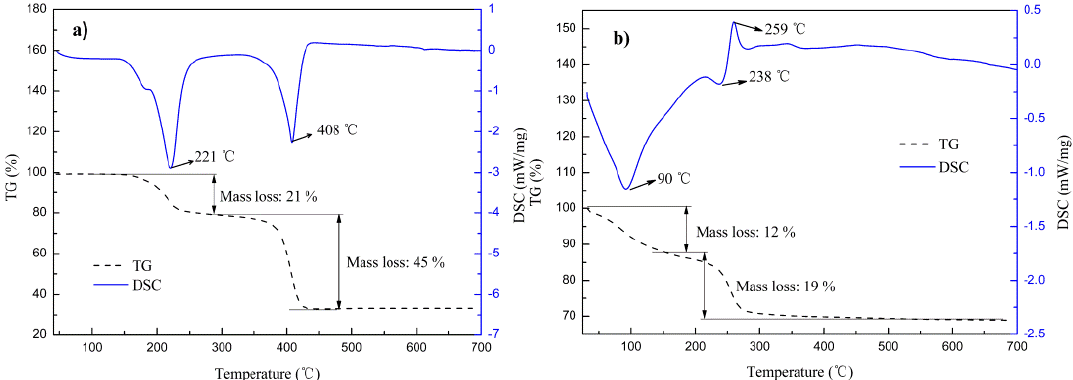
Figure 5. TG and DSC curves for samples of: ( a ) PO1; and ( b ) PC1.